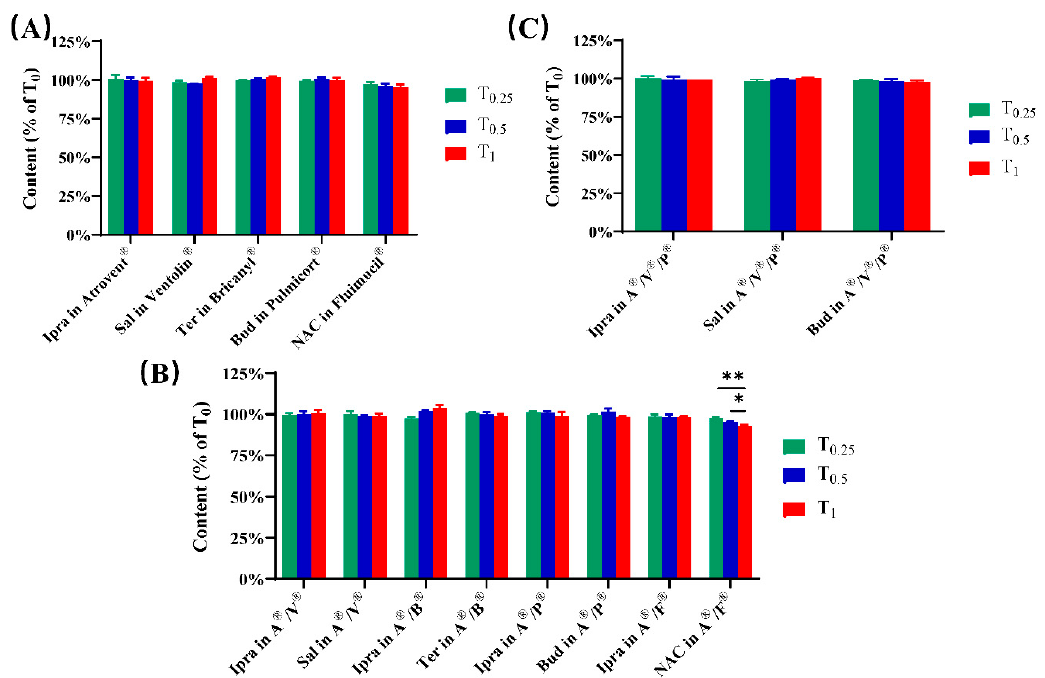
Figure 2. The content of active components in single dose of each drug ( A ), binary admixtures ( B ), and ternary admixtures ( C ) over time (mean ± s.d. shown). n = 5 in each group. * p < 0.05 with analysis of variance (ANOVA), ** p < 0.01 with ANOVA. Abbreviations: Ipra—ipratropium bromide; Sal—salbutamol sulfate; Ter—terbutaline sulfate; Bud—budesonide; NAC—N-acetylcysteine; A ® / V ® —Atrovent ® / Ventolin ® ; A ® / B ® —Atrovent ® / Bricanyl ® ; A ® / P ® —Atrovent ® / Pulmicort ® ; A ® / F ® —Atrovent ® / Fluimucil ® ; A ® / V ® / P ® —Atrovent ® / Ventolin ® / Pulmicort ® .